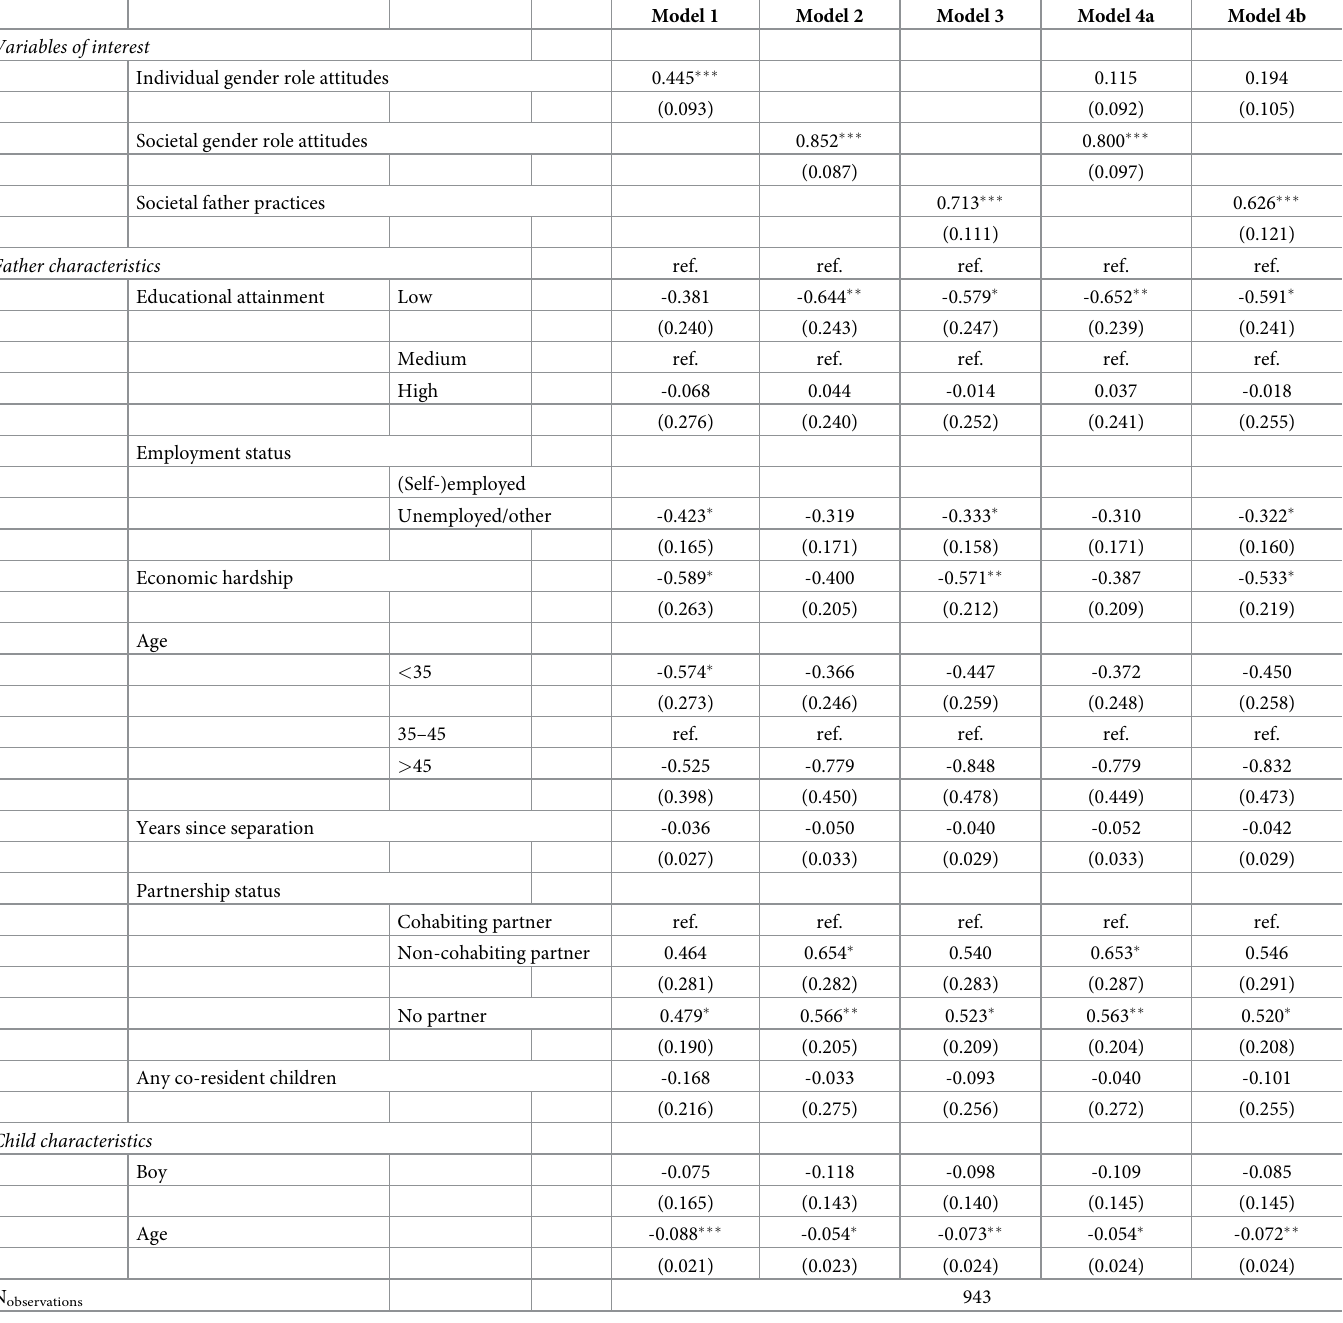
Table 5. Average marginal effects from the logistic regression predicting monthly nonresident father-child contact for the childhood-sample (reference: no monthly